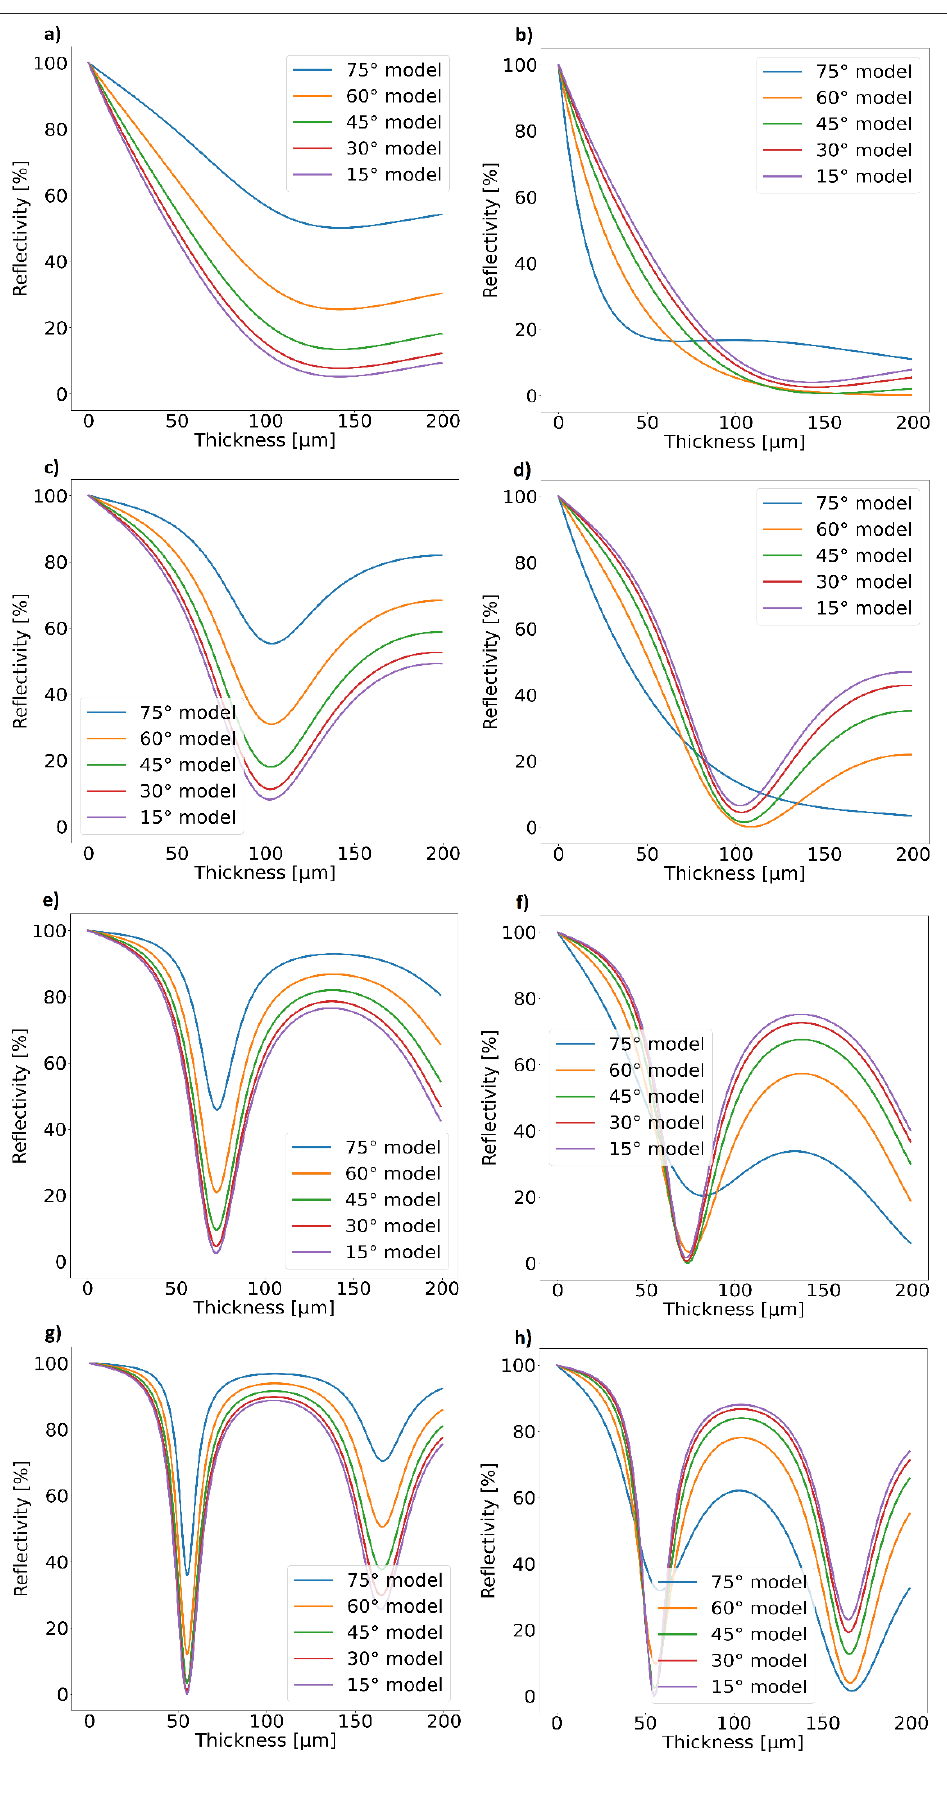
Fig. 5. Modeled data for the result of a change in refractive index on the thickness dependency with an absorption coefficient of 100. Left column is orthogonal, right one parallel polarization, the absorption coefficient from top to bottom is